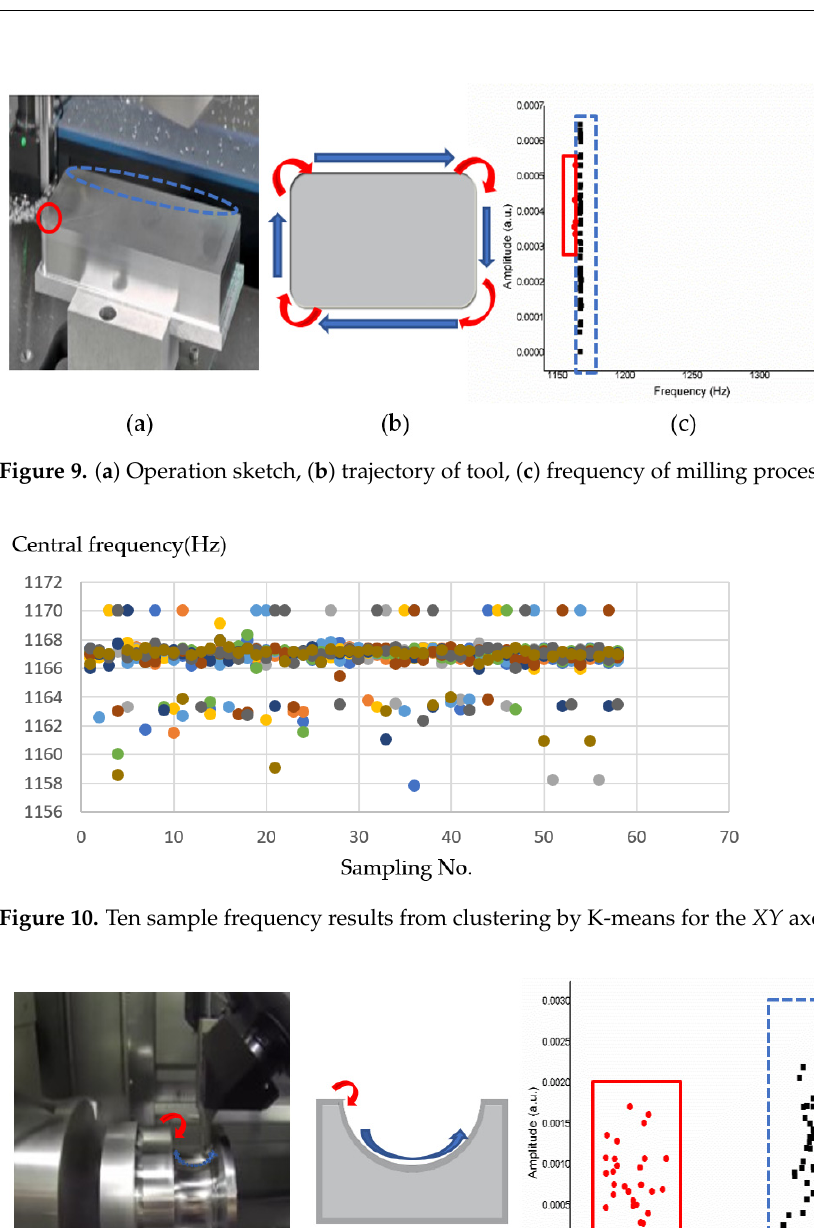
Figure 10. Ten sample frequency results from clustering by K-means for the XY axes.